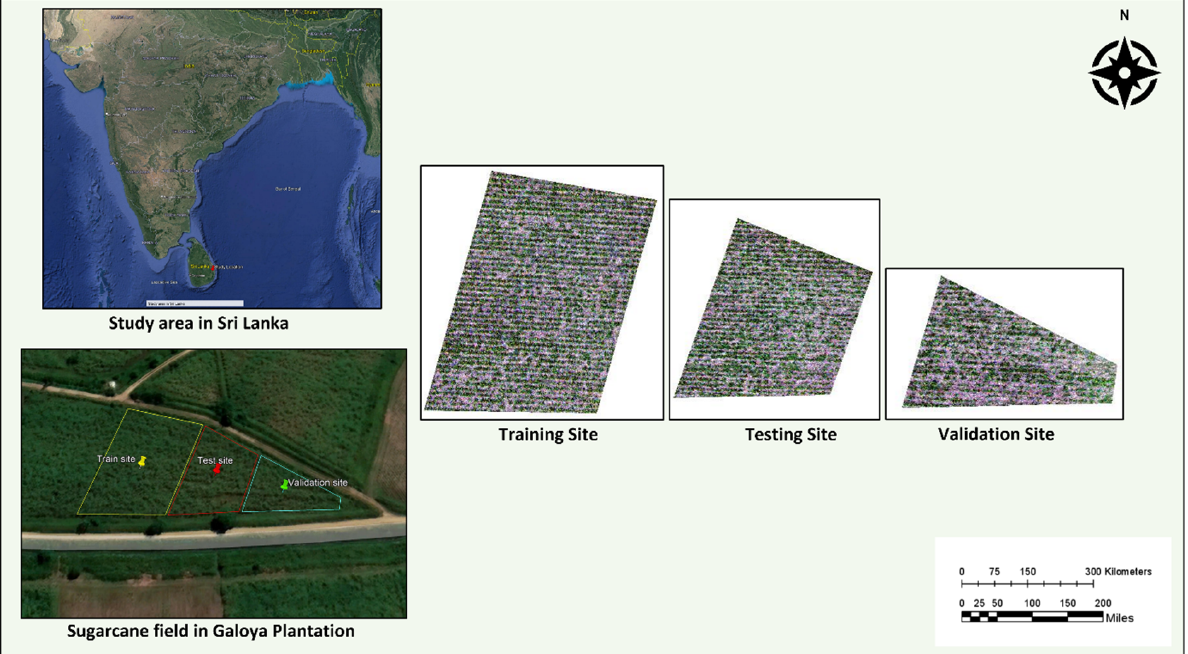
Figure 2. Study area at Galoya Plantation, Hingurana, eastern Sri Lanka. (7°16 ′ 42.94”N, 81°42 ′ 25.53”E).